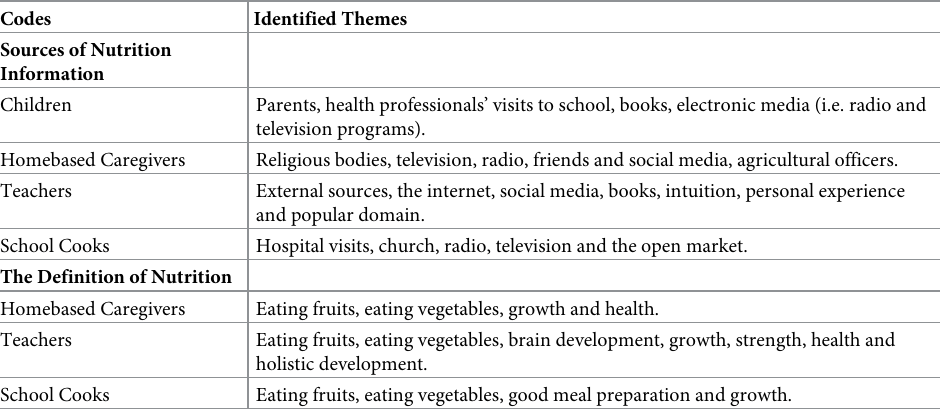
Table 3. Summary of identified themes from key informant interviews &